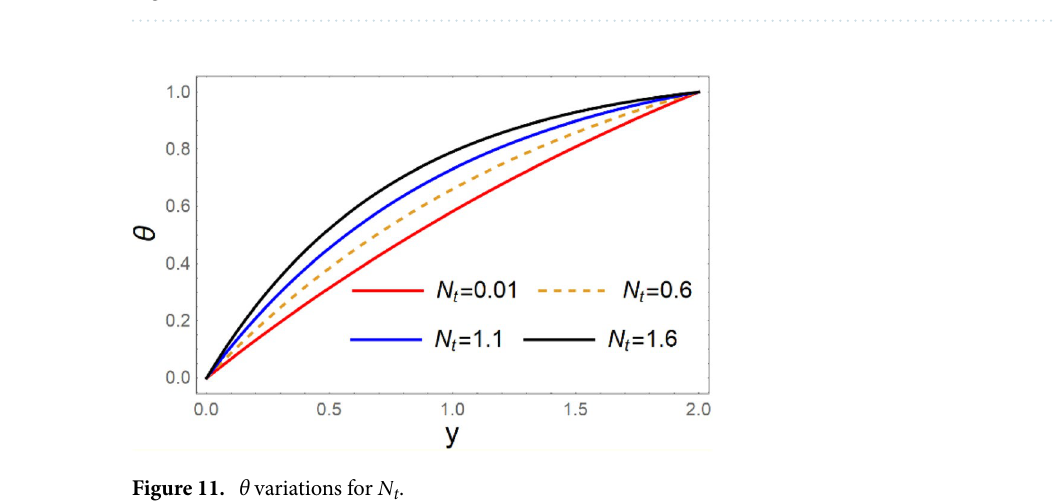
Figure 10. θ variations for N b .